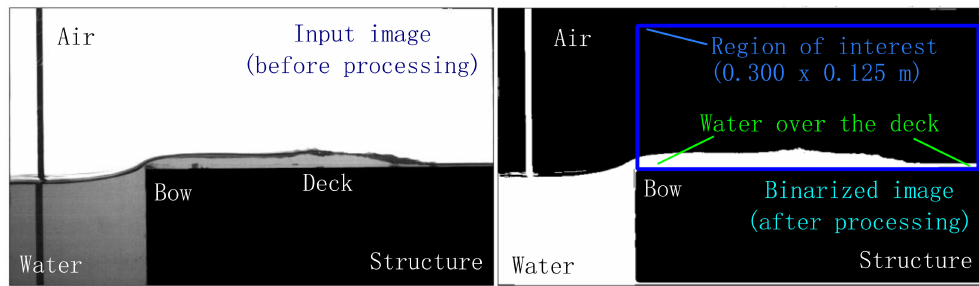
Figure 5. Definition of the region of interest to measure the green water volume over the deck. ( Left ): Input image; ( right ): Binarized image with the region of interest in which the volumes (white area in the figure) were